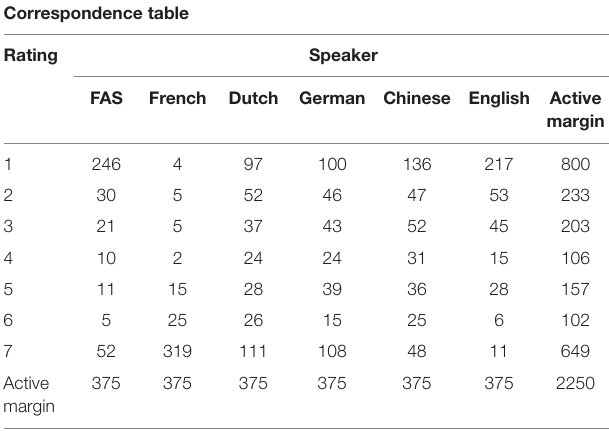
The data are transformed to vectors in a two-dimensional space ( Figure 1 ).